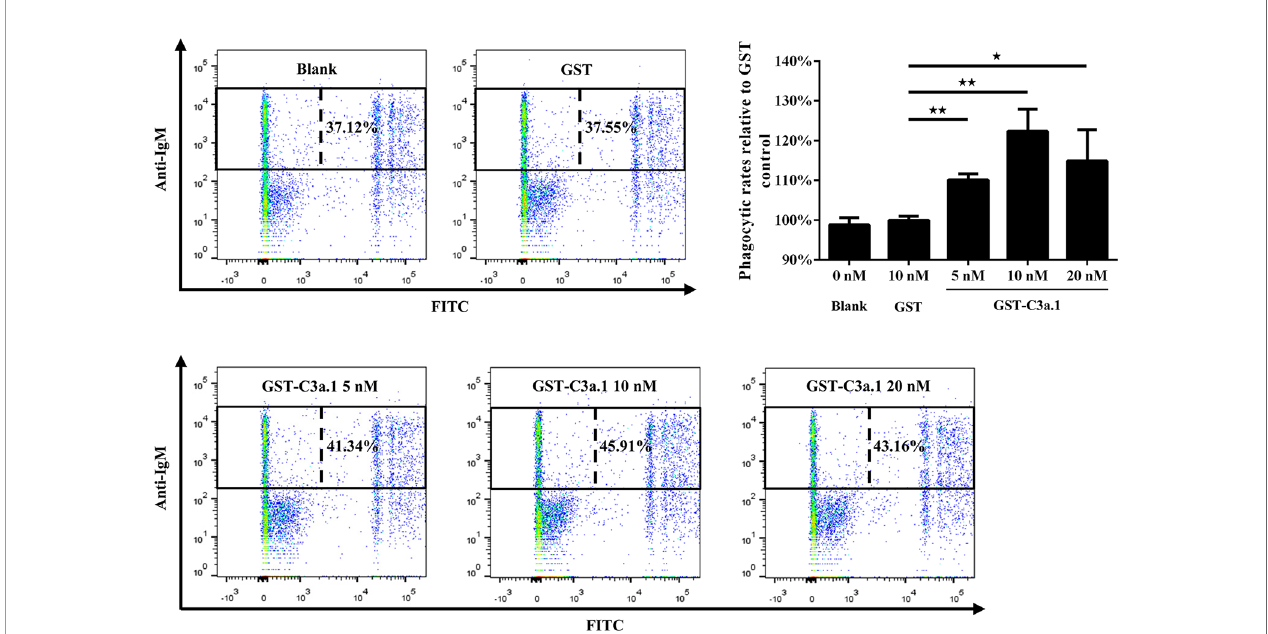
FIGURE 5 | C3a.1 enhances the phagocytic activity of grass carp IgM + B cells. HKLs were incubated with GST-C3a.1 and fl uorescent beads at 28°C for 2 h. The PBS and GST were used as the blank and negative controls, respectively. After incubation, the non-ingested beads in cell suspensions were removed, and the cells were stained with mouse anti-grass carp IgM mAbs. Finally, the phagocytic activity of grass carp IgM + B cells was detected using fl ow cytometry. One representative result was shown in the dot plot of fl ow cytometry. Data are presented as mean ± SEM (n = 3 fi sh), and the statistic p value was calculated by one-way ANOVA with a Dunnett post hoc test (* p < 0.05, ** p < 0.01).